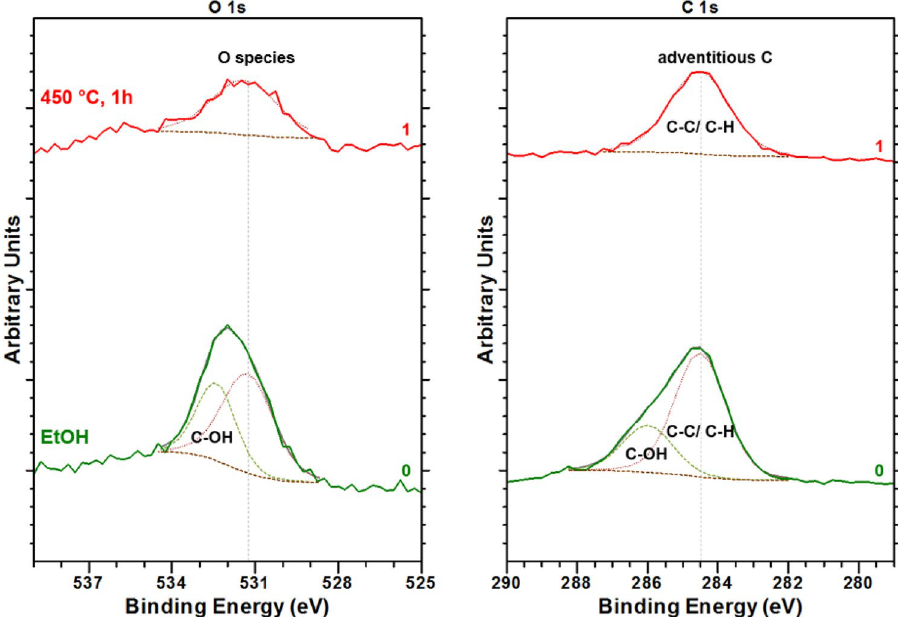
Figure 1. O 1 s and C 1 s photoelectron spectra for the p-GaN surface cleaned with EtOH (line 0) and after thermal cleaning at 450 °C (line 1). Dashed lines represent the peak fitting of the photoemission